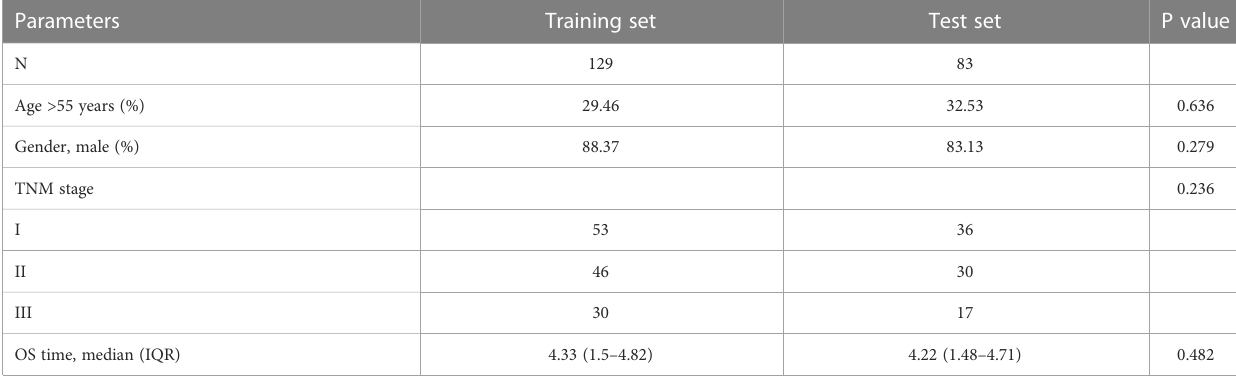
TABLE 1 There was no signi fi cant difference between the two groups of clinical phenotypes.